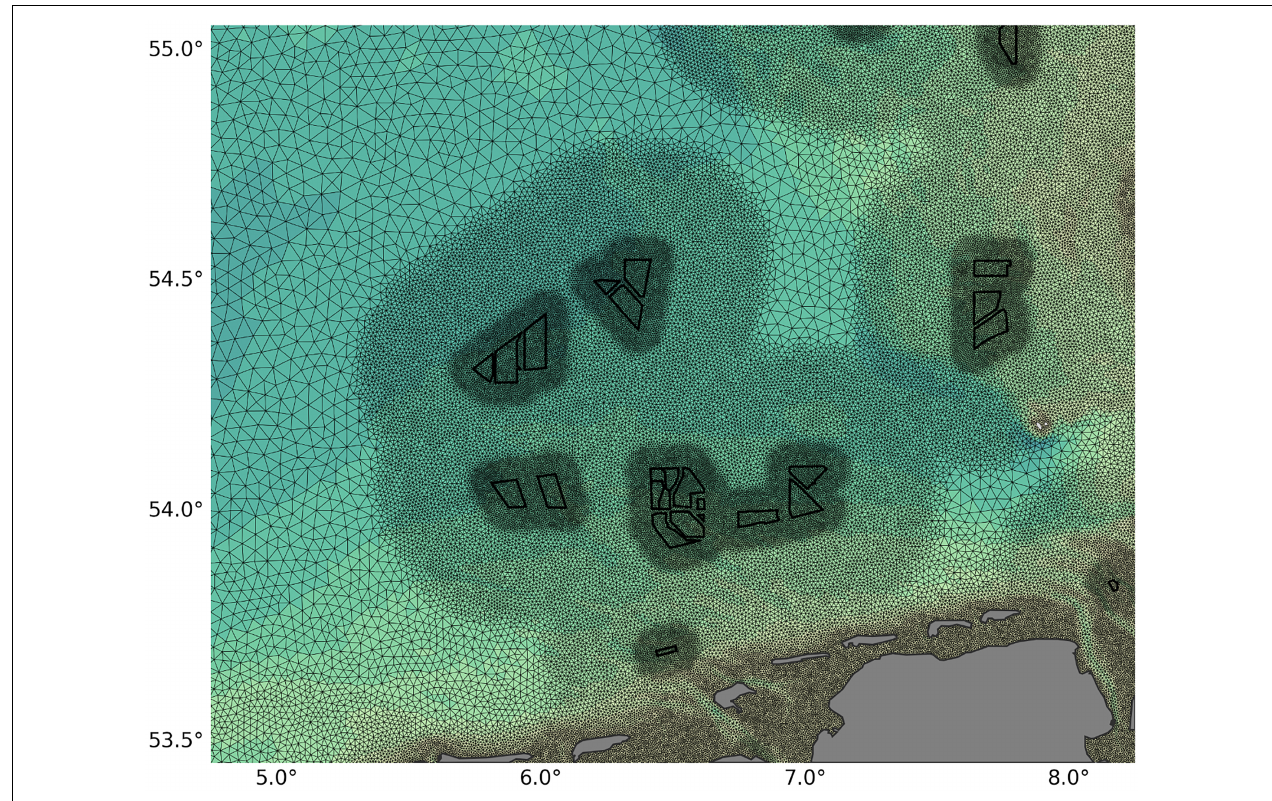
FIGURE 3 | Example of the horizontal grid cell resolution at wind farm polygons (black) for the wind farm simulations.